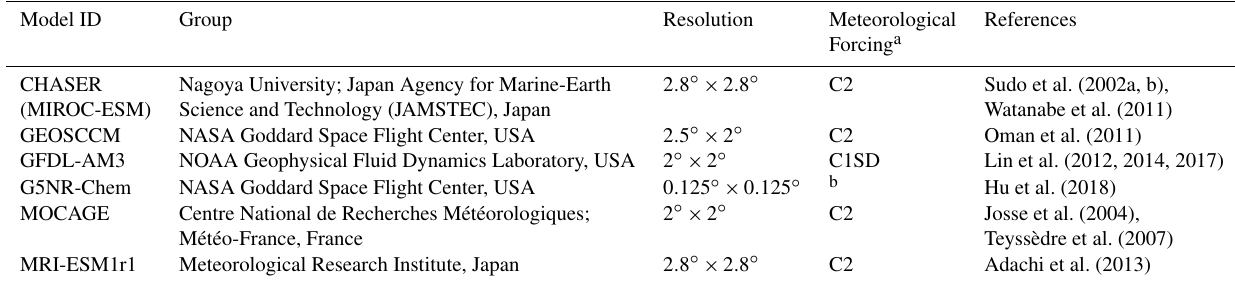
Table 1. List of the ensemble members used in this paper. Model